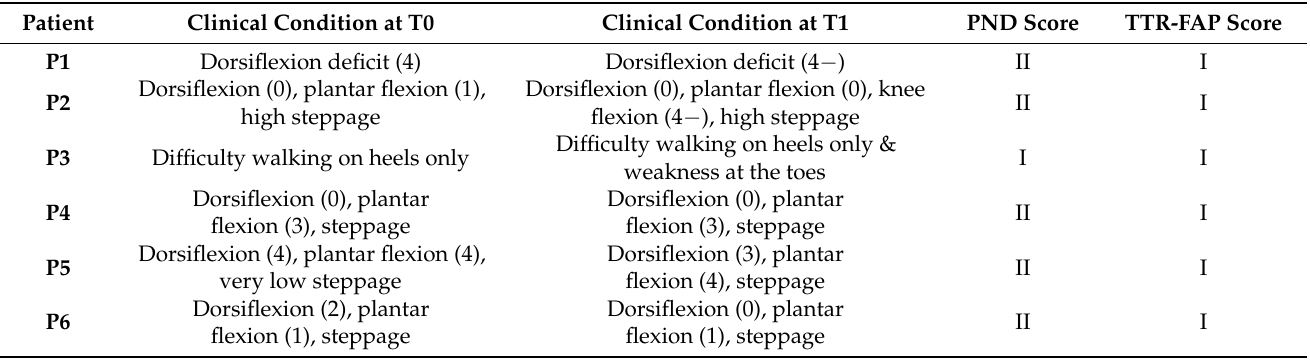
Table 2. Clinical evolution of the ATTRV amyloidosis patients evaluated based on the Medical Research Council (MRC) Scale (0 is the worst condition and 5 the best). The PND (Polyneuropathy Disability) and ATTRV amyloidosis scores are also indicated (the values were the same at T0 and T1). PND score (0: no impairment, I: sensory disturbances but preserved walking capability, II: impaired walking capability but ability to walk without a stick or crutches, III a: walking only with the help of one stick or crutch, III b: walking with the help of two sticks or crutches, IV: confined to a wheelchair or bedridden); TTR-FAP score (I—sensory polyneuropathy, II—progressive walking disability, and III—wheelchair-bound or